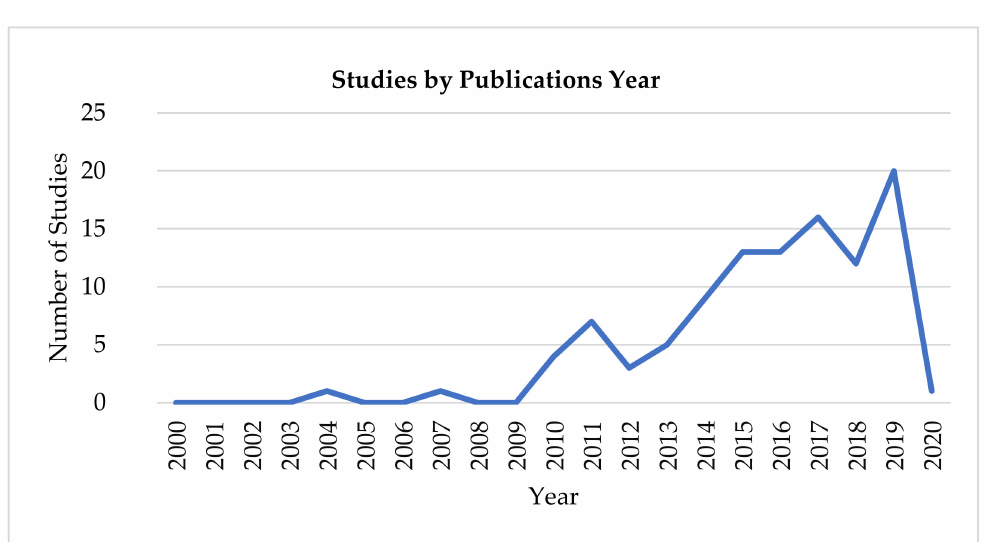
Figure 2. Number of studies by publication